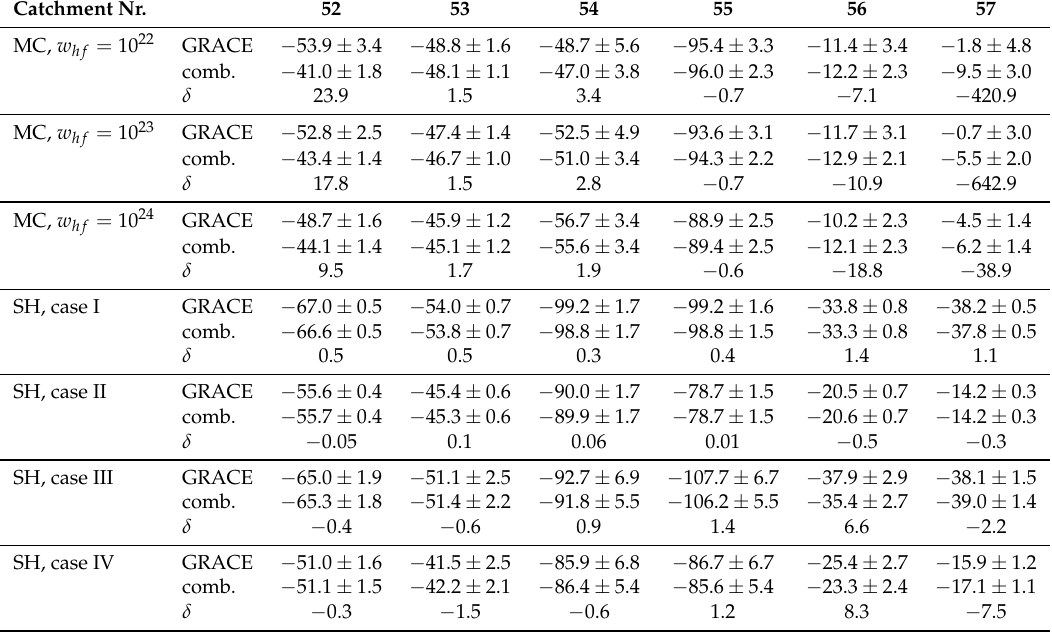
Table 2. Mass trend values obtained by the mascon (MC) and SH approaches for the six glacial catchment areas in Greenland (see Figure 7). Uncertainties are given as 1-sigma errors that are formally propagated from the variance-covariance matrices of the individual models. “GRACE” stands for GRACE-only results, “comb.” stands for results based on GRACE/GOCE SGG combination models, and δ denotes the relative difference of the GRACE and combination model-derived trend values (see Section 3.3.3). The meaning of the factor w hf is explained in Section 2.2.5; SH cases I to IV are defined in Table 1. All trend values (GRACE, comb) are given in Gtyr − 1 , δ is given in %. Catchment